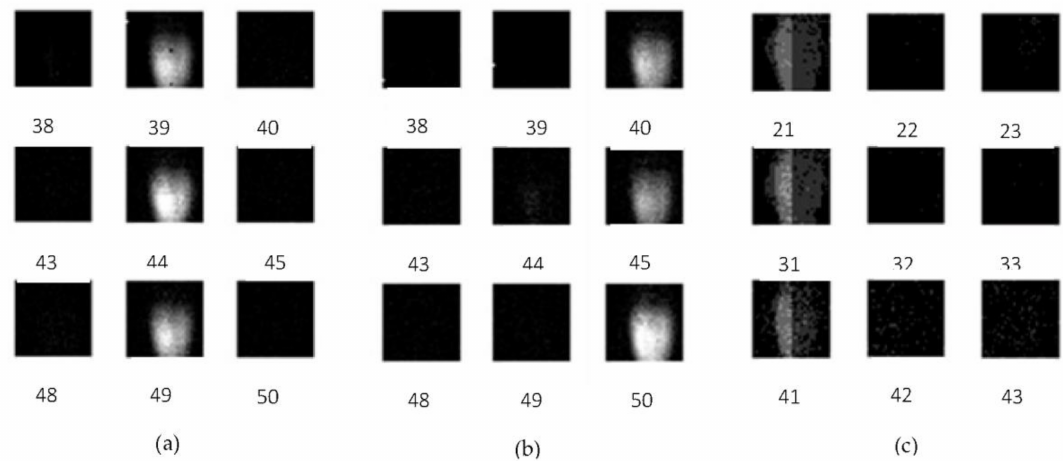
Figure 9. The laser diode (LD) images (the LD directly illuminates the sensor through a very dark ND filter). ( a ) Every five frames for 12.5 Mfps; ( b ) every five frames for 25 Mfps; ( c ) and every 10 frames for 50